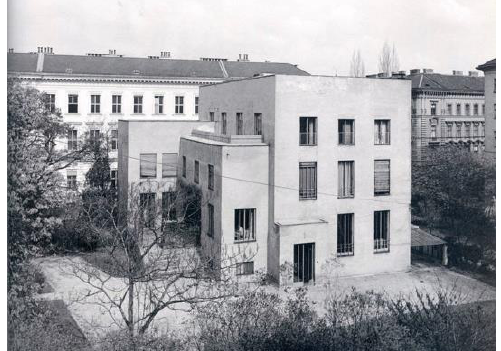
Fig. 22 Wittgenstein’s house, (Engelmann and Wittgenstein,